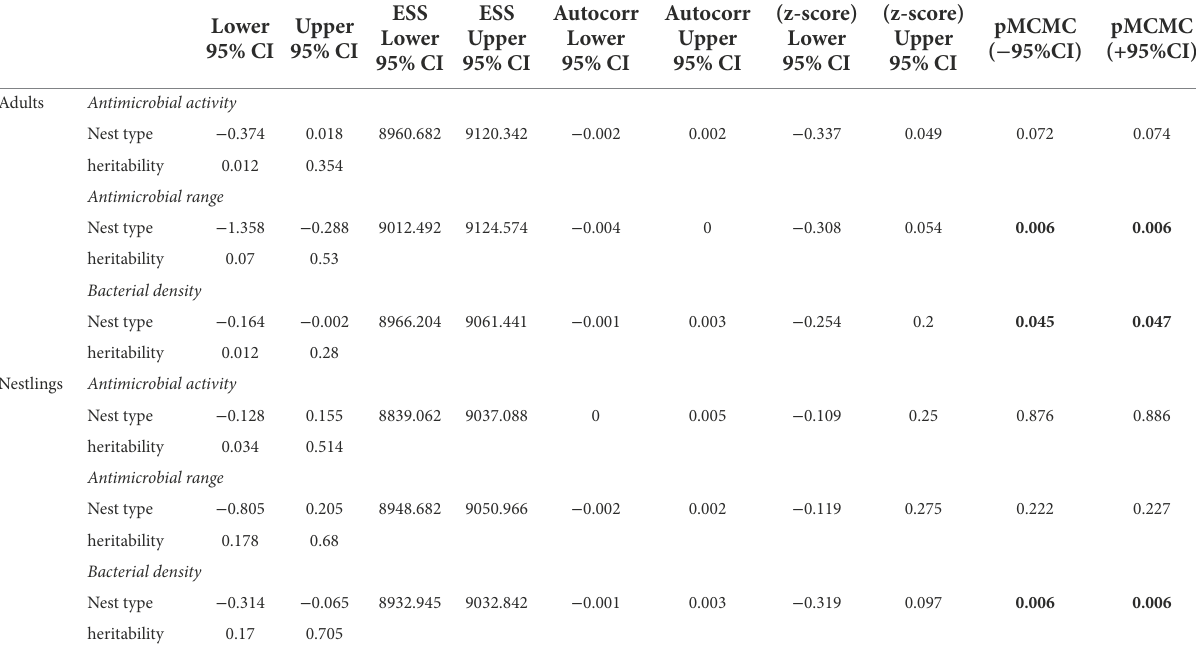
TABLE 4 Results of MCMCglmm models with nest type as a fixed factor, the bird phylogeny as a random factor and the antimicrobial activity (average values of the width of antagonistic halos when tested against each of the nine indicator bacteria), antimicrobial range (Shannon index of the antimicrobial activity), and bacterial density as dependent